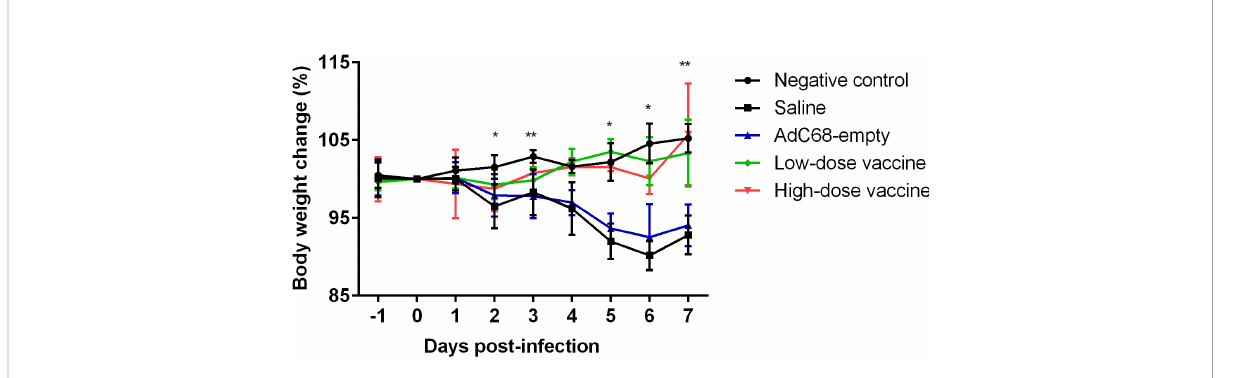
FIGURE 5 Body weight changes in golden Syrian hamsters after live challenge. Data presented as mean ± SD of values. * P <0.05 or ** P <0.01 between Negative control and Saline. Intergroup statistical analysis was performed using a two-way ANOVA test, using the infected, saline-treated group as a